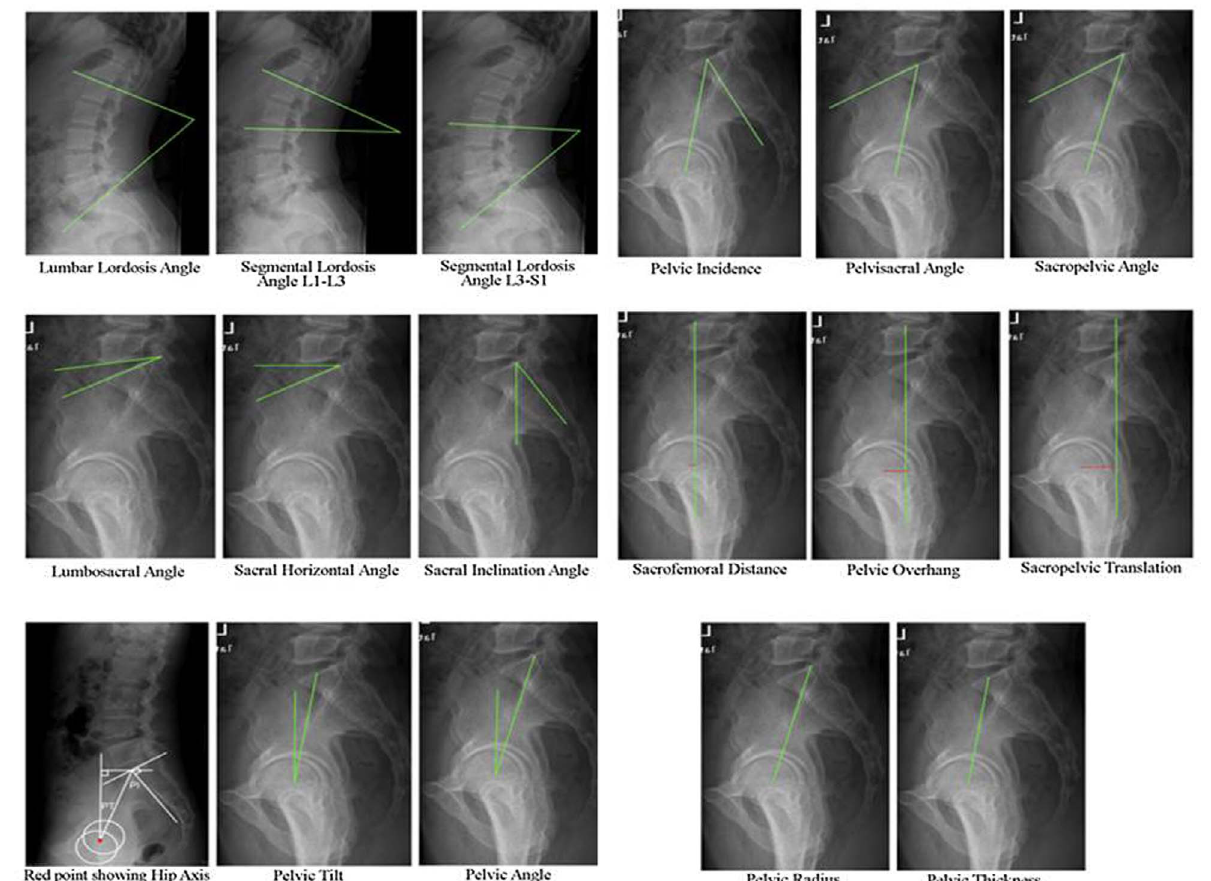
Figure 1. Shows schematic representation of various spino-pelvic parameter measurements on the